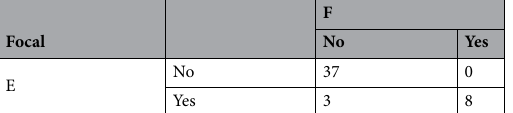
Table 4. Frequency table showing the pairs of observers with the highest Kappa (0.80) regarding the interpretation of focal skeletal/bone marrow uptake. Grey fields indicate agreement between physicians E and